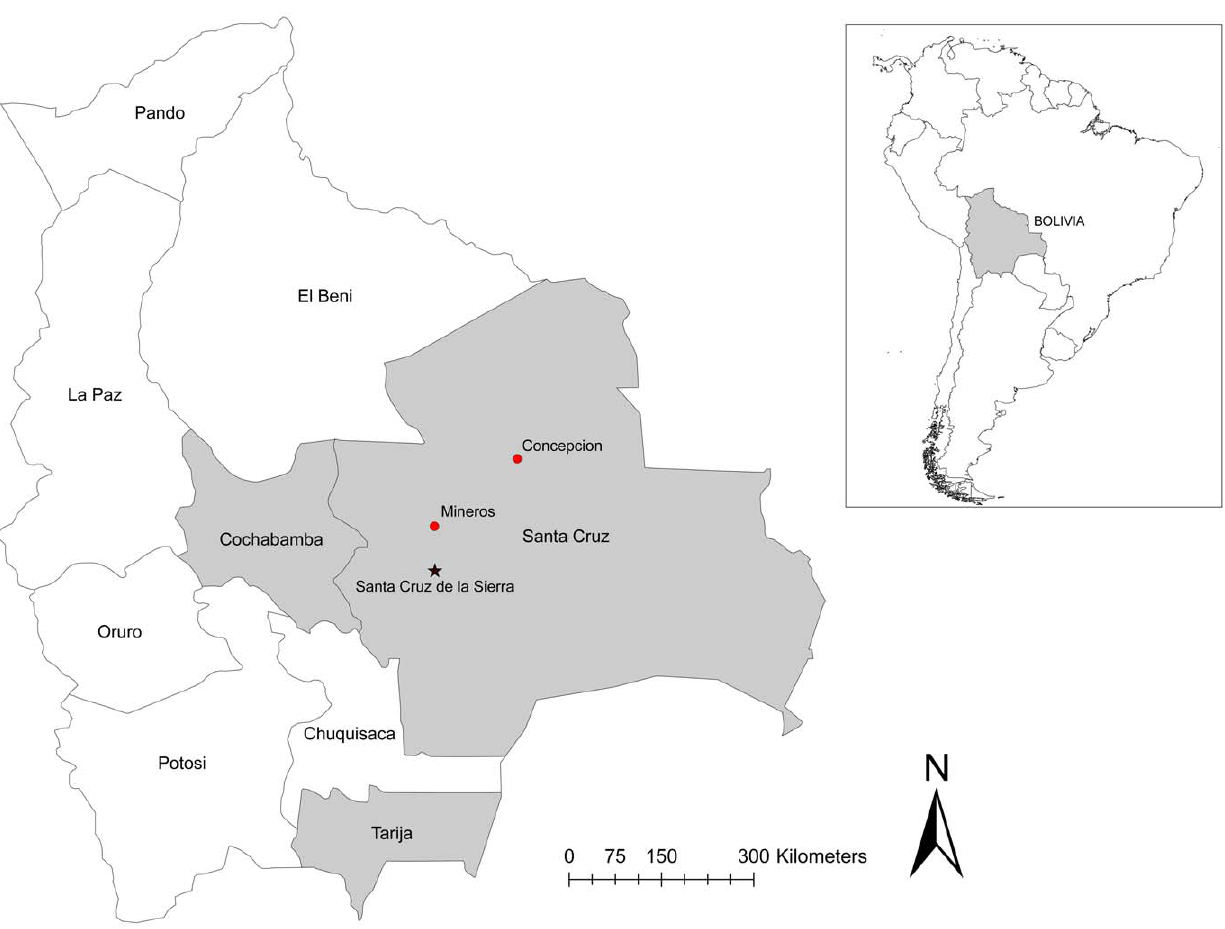
Figure 1. Locations of reported cases of hantavirus pulmonary syndrome and field studies associated with the 2002 outbreak in Bolivia. The two index cases reported here were from Mineros and Concepcio´n. The capital city of Santa Cruz is indicated by a star. Laboratory- confirmed hantavirus infection in humans and rodents has been reported from Santa Cruz, Tarija, and Cochabamba Departments, shown in gray.